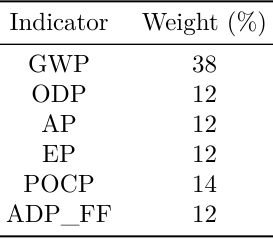
Table 3. Weight for each environmental indicator